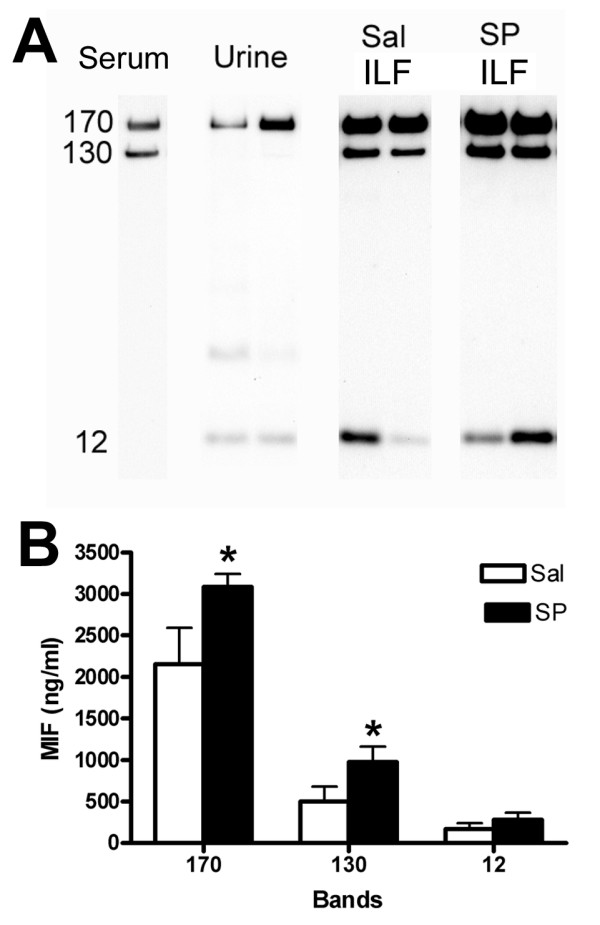
Substance P-induced release of MIF/A1-I3 complexes in the intraluminal fluid. A) MIF WB of serum, urine collected before treatment and intraluminal fluid of saline treated vs SP-treated rats demonstrated differences in the forms of MIF found. Serum only contained high-molecular weight MIF complexes of 170 and 130-kDa apparent molecular weight. No 12-kDa MIF was detected in the serum. In pre-treatment urine, however, only 170-kDa MIF/A1-I3 (as verified by A1-I3 WB; data not shown) and 12-kDa MIF bands but no 130-kDa were observed. B) In the intraluminal fluid (ILF), 170 and 130-kDa bands, corresponding to MIF/A1-I3 complexes [10] were noted along with 12-kDa MIF. SP treatment increased both 170 and 130 kDa MIF/A1-I3 amounts in the ILF (Figure B).